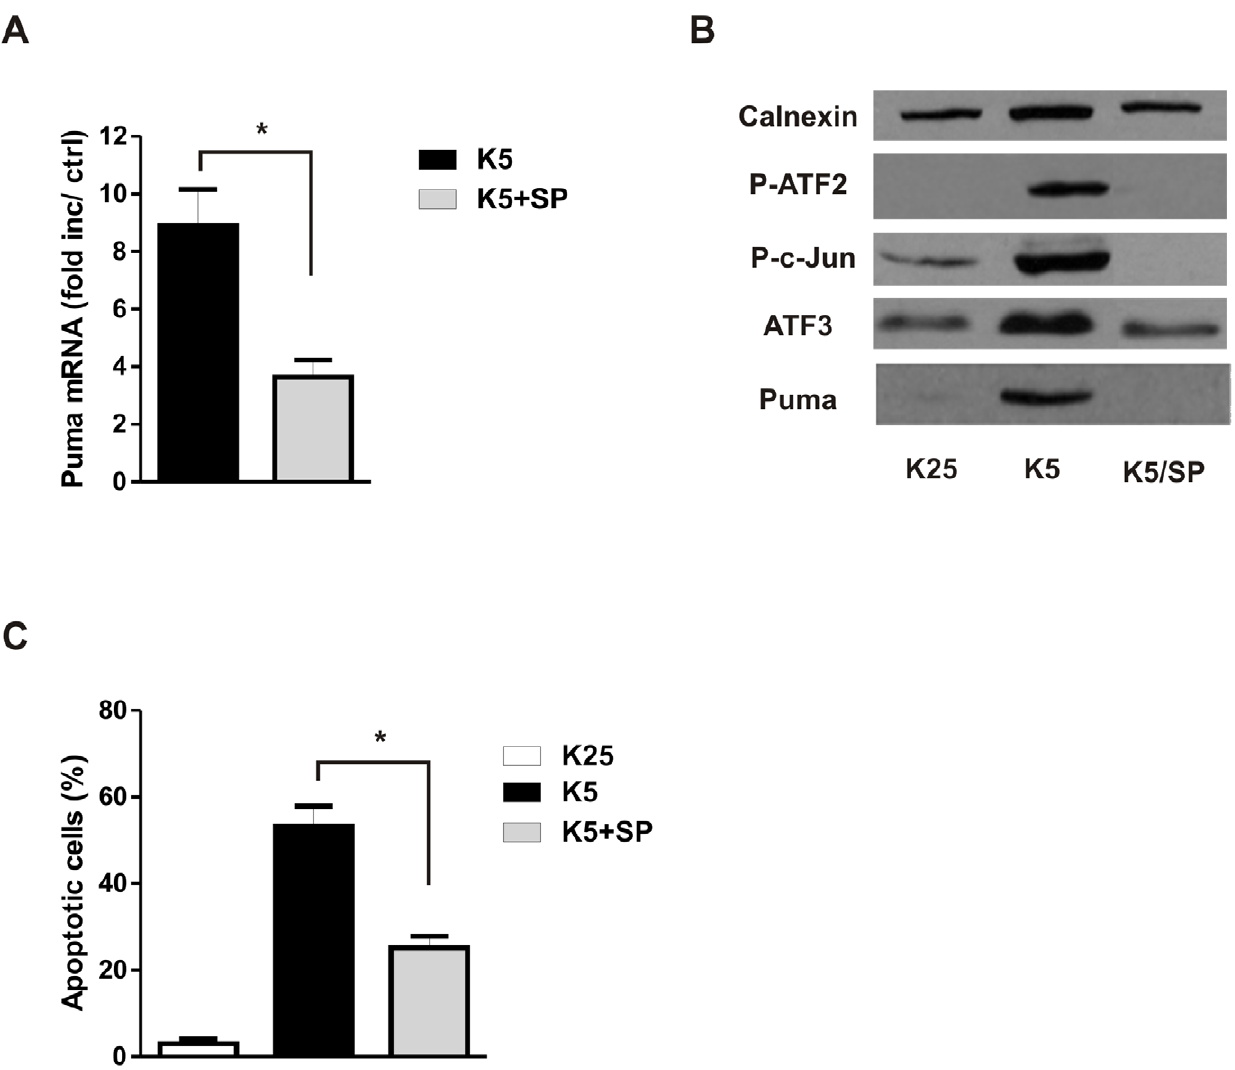
Figure 4. JNK is required for Puma induction and potassium withdrawal induced neuronal apoptosis. After 7 days in culture CGNs were either maintained in high potassium medium or switched to low potassium medium with or without 10 m M SP600125 (SP). A, Puma mRNA levels were assessed by qRT-PCR 6 hours after potassium withdrawal and are reported as fold increase over K25 controls (n=7, *p , 0.05). B, Protein extracts were collected 8 hours after potassium withdrawal and Phospho-ATF2, Phospho-c-Jun, ATF3 and Puma protein levels were assessed by western blot. Calnexin was included as a loading control. C, The fraction of apoptotic neurons was determined 24 hours after potassium withdrawal by examining nuclear morphology in Hoechst stained cells (n=5, *p ,